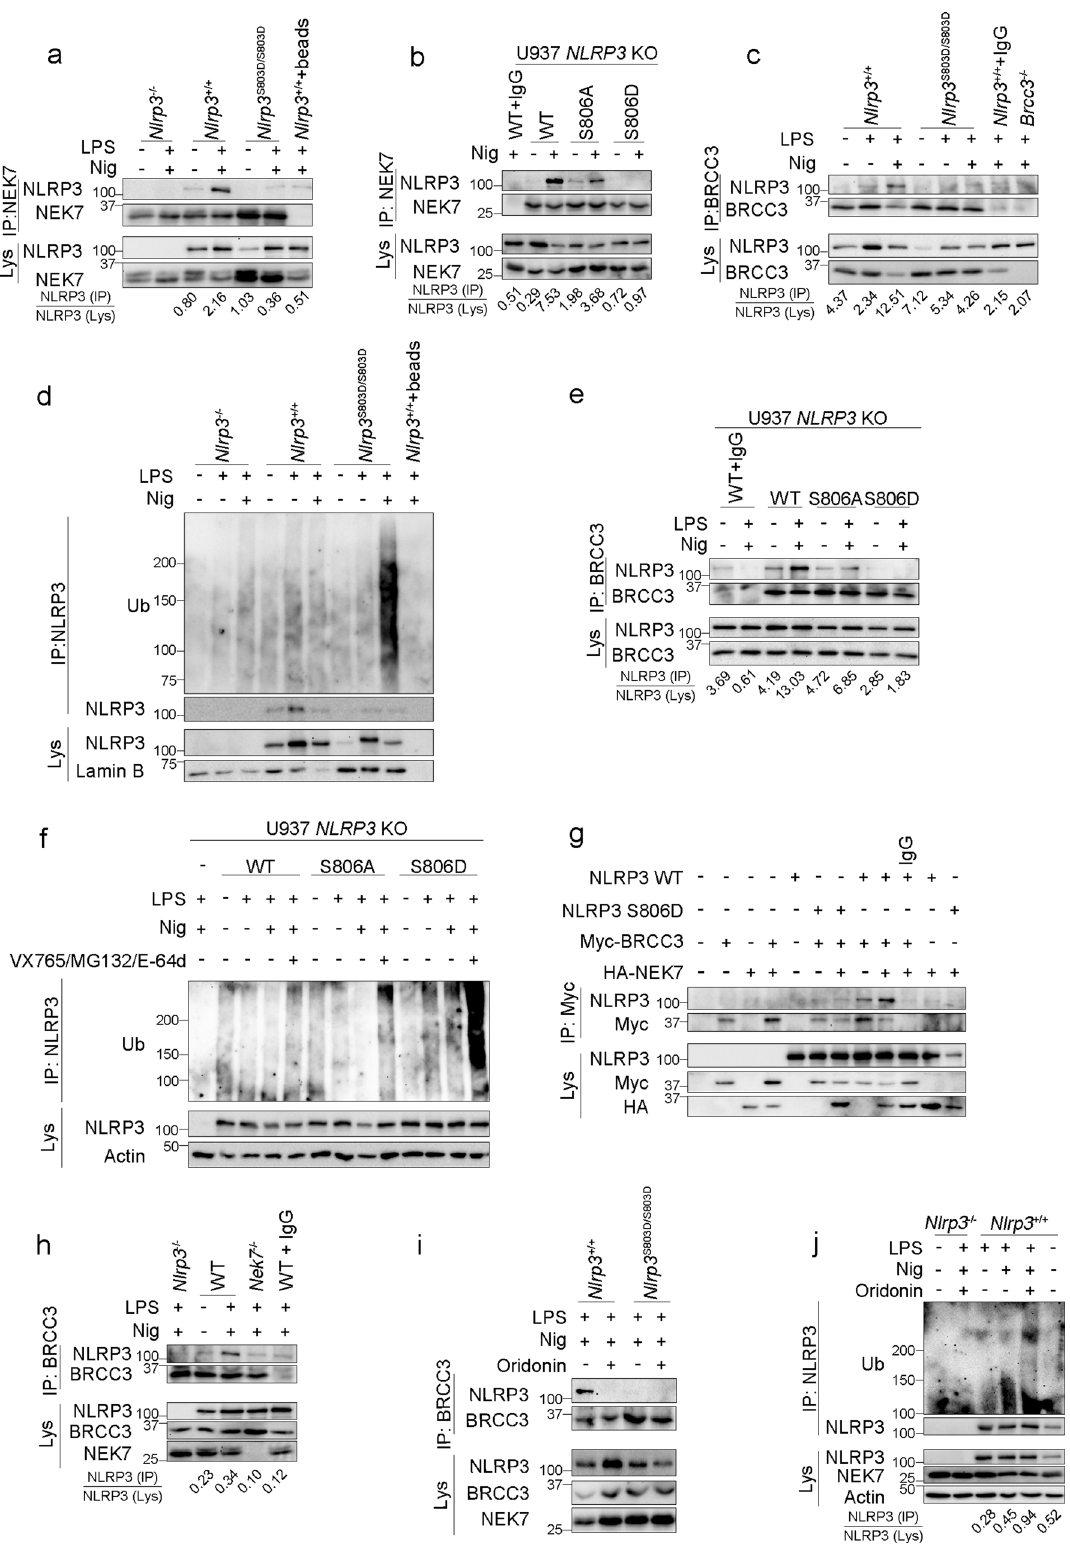
expressed in 293T cells (Fig. 7f), and endogenous NLRP3 co- immunoprecipitated with CSNK1A1 in BMDMs primed with LPS (Fig. 7g). Finally, HA-CSNK1A1 co-expression with NLRP3 in 293T cells resulted in the phosphorylation of NLRP3 WT but not NLRP3 S806A mutant (Fig. 7h). Consistently, CSNK1A1 inhibitor D4476 completely abrogated NLRP3 phosphorylation on serine